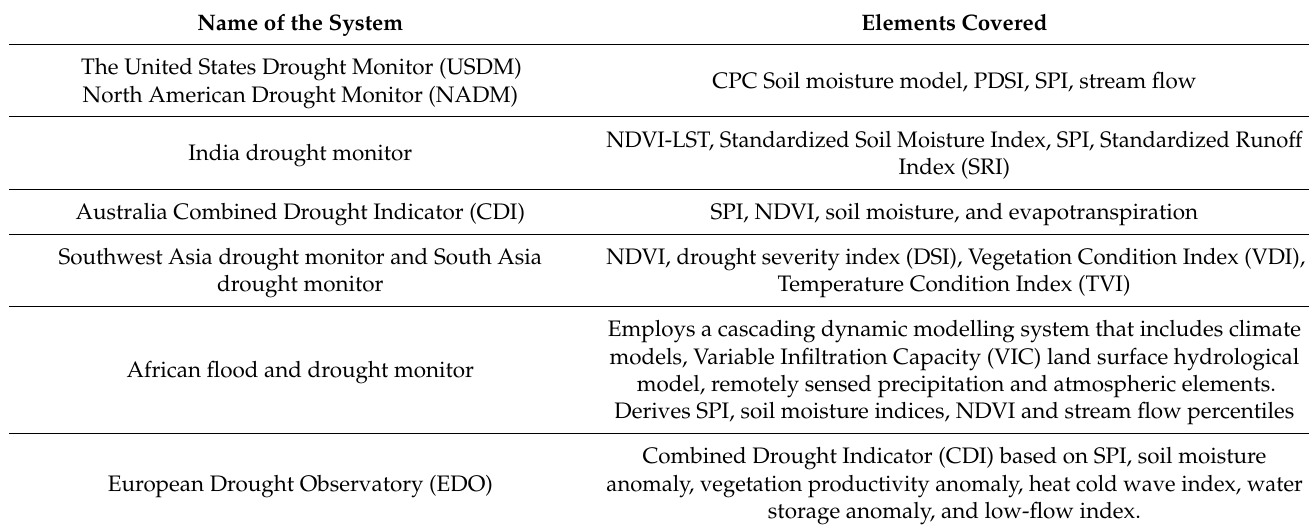
Table 2. Elements covered by some of the drought monitoring and early warning